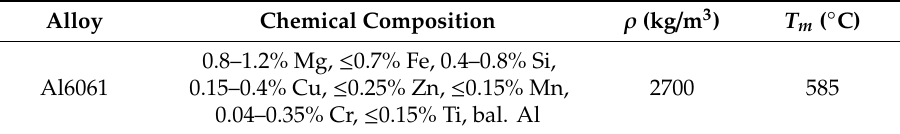
Table 2. Physicochemical properties of the alloy used in the experiments. Alloy